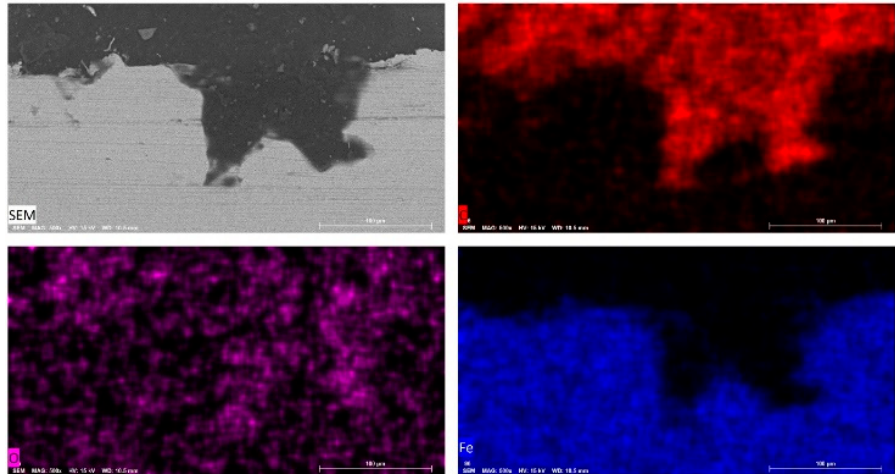
Figure 10. Cross-sectional SEM image with elemental maps for carbon steel sheet surfaces after 12 h of immersion in 10 − 3 M HCl solution (pH = 2.95).